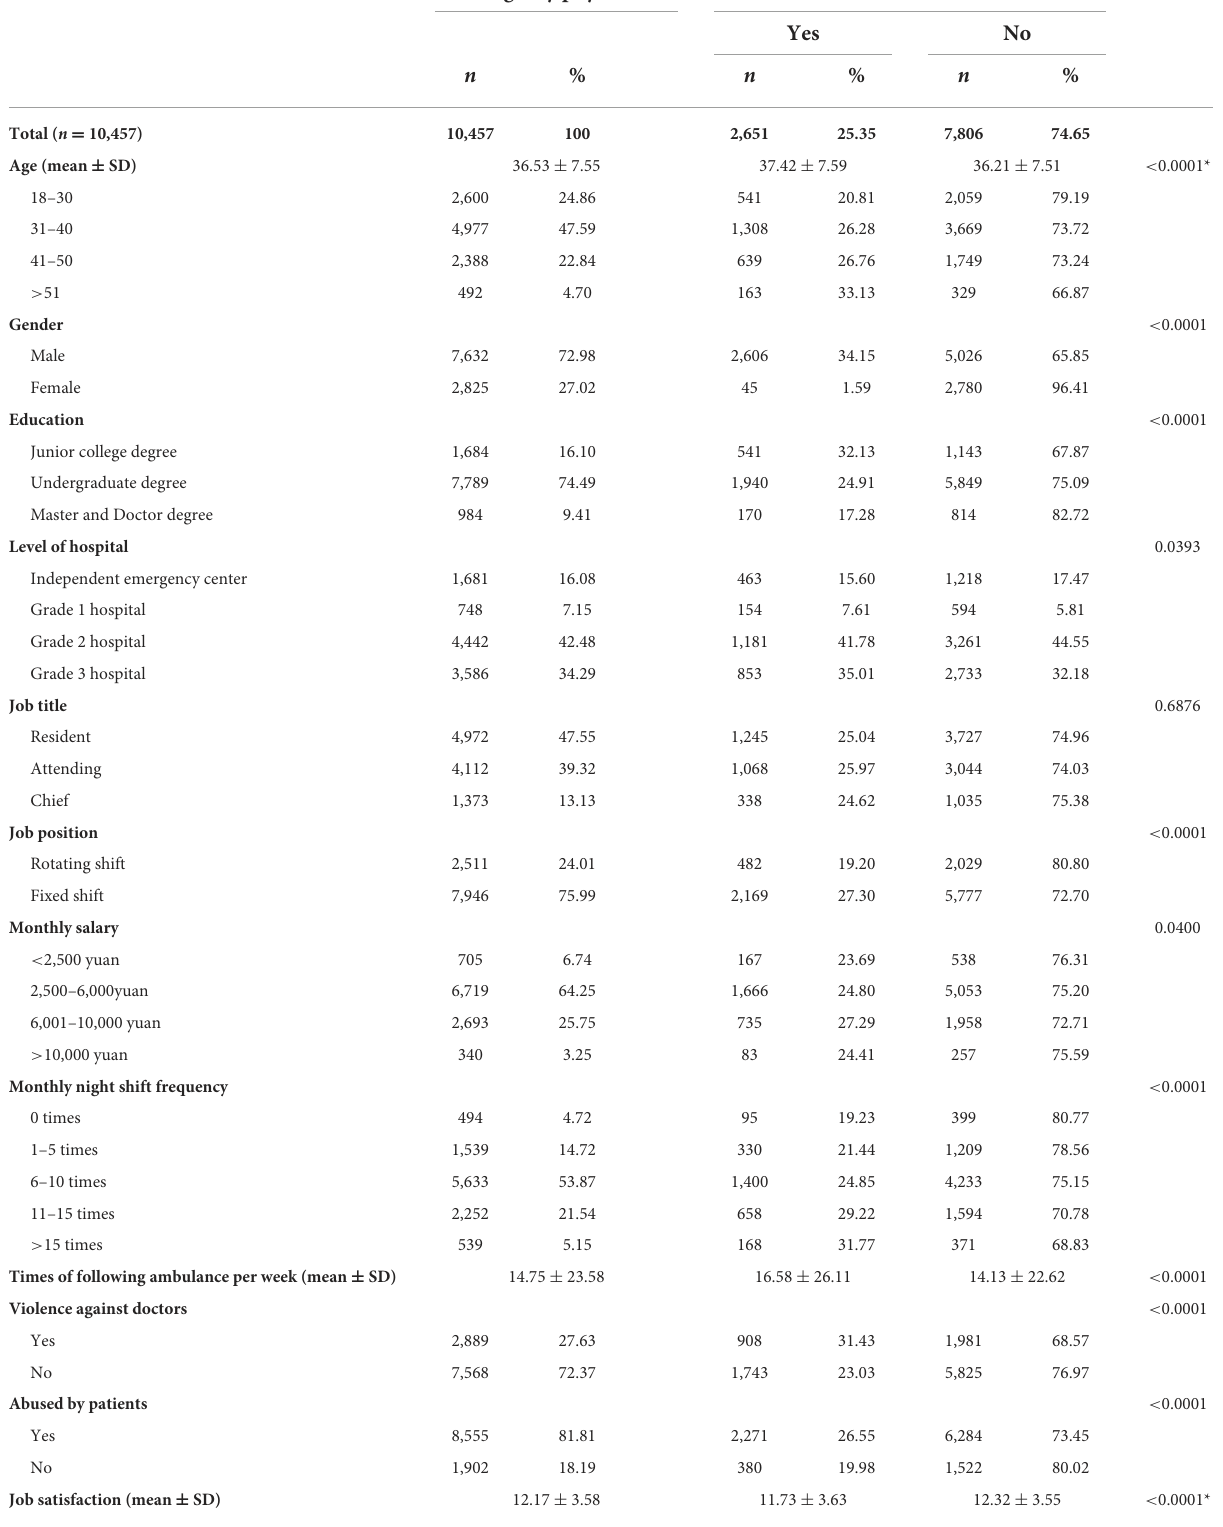
TABLE 1 Basic information of the sample and prevalence of tobacco smoking among Chinese emergency